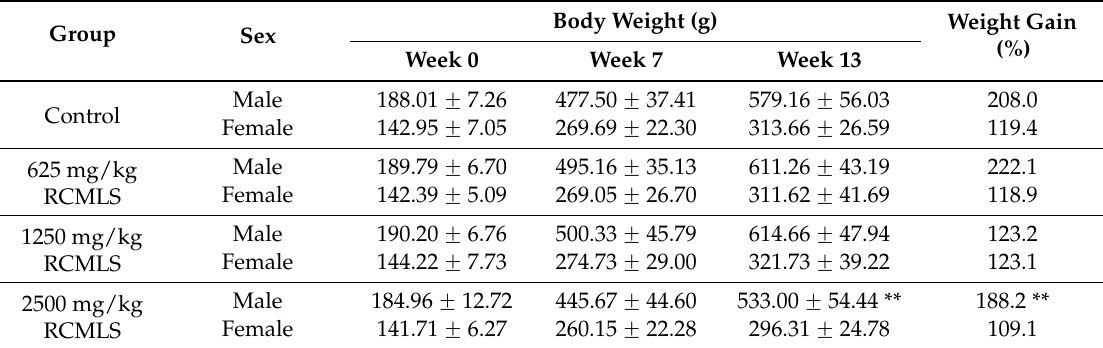
Table 5. Body weight of male and female rats in 13 weeks repeated oral dose toxicity study of the leaves and stems of Rubus coreanus